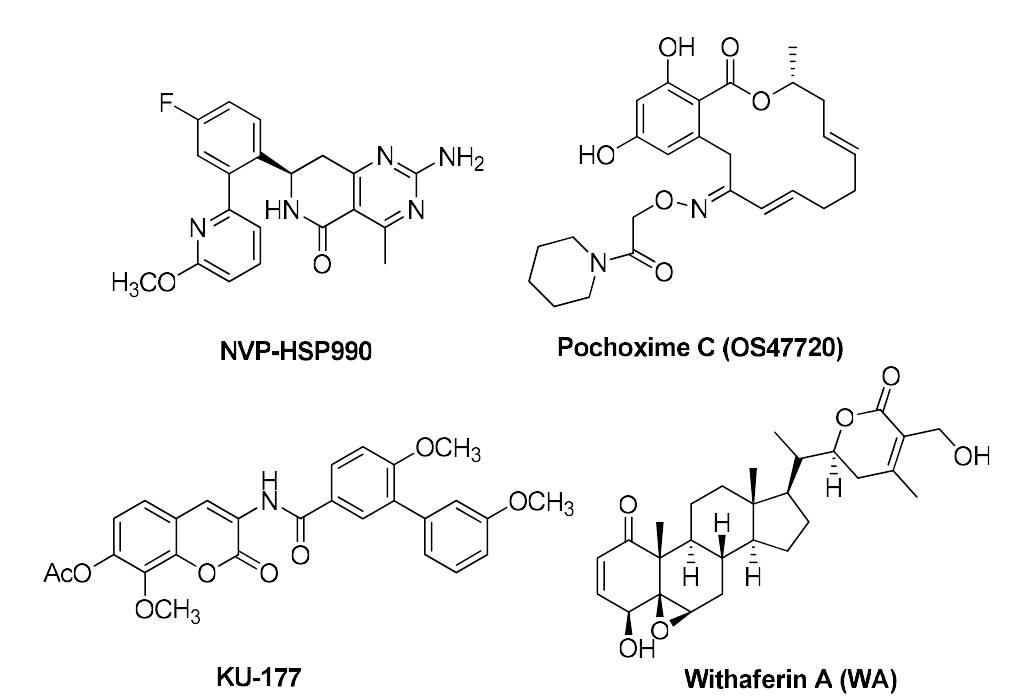
Figure 10. Chemical structures of Hsp90 inhibitors/modulators.